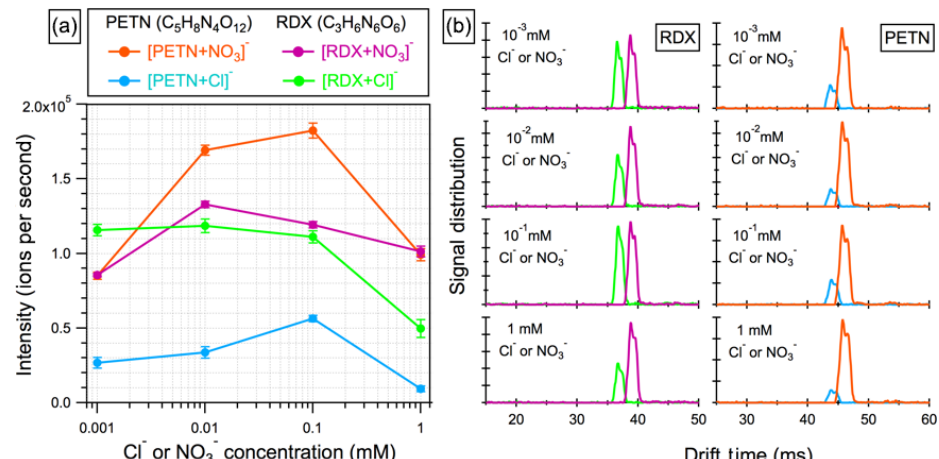
Figure 2. (a) Signals of the ion adducts produced from RDX and PETN by clustering with chloride (Cl − ) and nitrate (NO − the corresponding anion concentrations ranging from 1µM to 1mM. (b) Drift-time distributions of the ion adducts [ RDX + Cl ] − , [PETN + Cl] − , [RDX + NO 3 ] − and [PETN + NO 3 ] − are consistent at different anion concentrations.